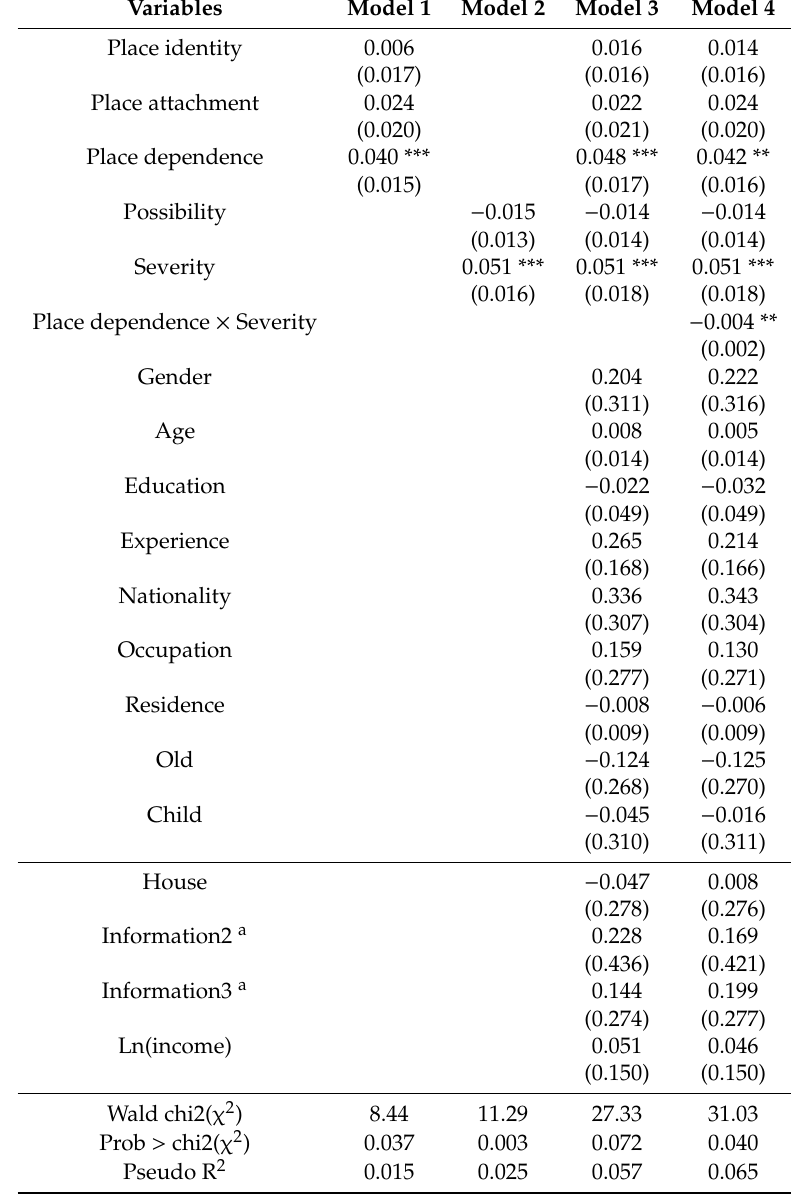
Table 6. Regression results of residents’ disaster risk perception, sense of place, and evacuation